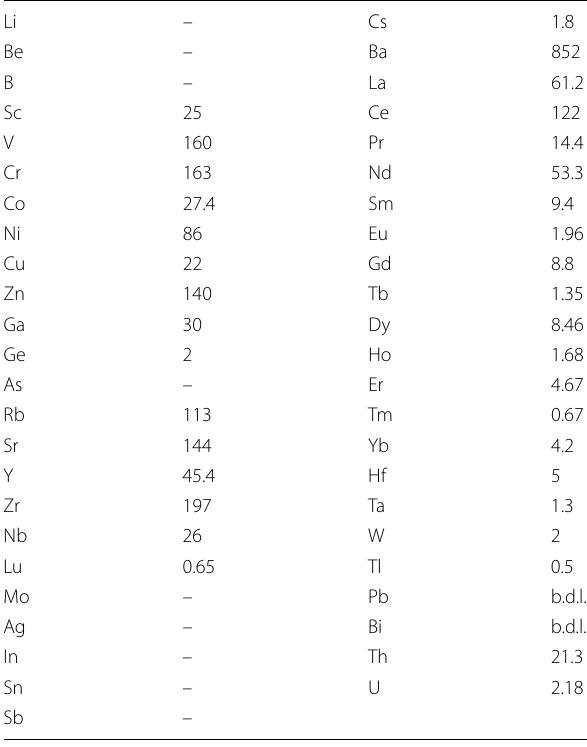
– Below detection limit